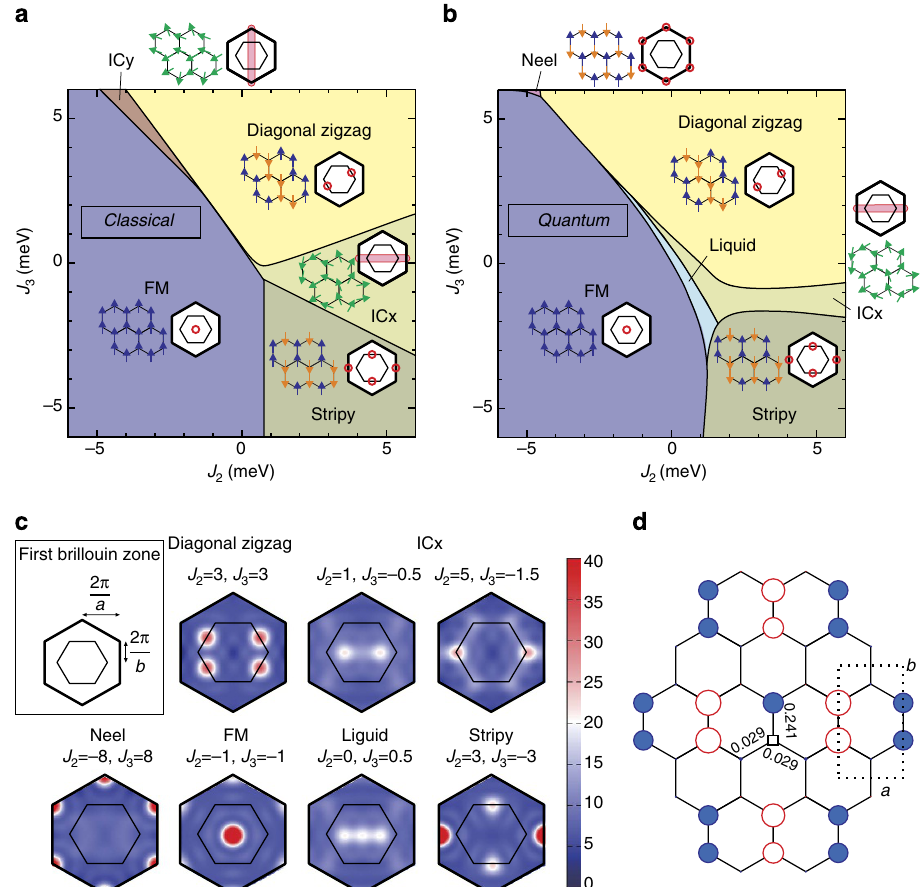
Figure 3 | Magnetic phase diagrams and spin structure factor. Phase diagram of Li213 in the J 2 – J 3 plane with the NN couplings listed in Table 1, along with schematic spin configurations and Bragg peak positions (red circles) for each phase. ( a ) Classical phase diagram of the effective spin T ¼ 1 model on the triangular lattice, found by a numerical minimization of the interaction matrix K (k) in the Brillouin zone (BZ). The actual ground-state configurations in the incommensurate regions ICx and ICy can be much richer than the standard coplanar helix states owing to anisotropy, see text. ( b ) Quantum mechanical phase diagram for the original spin-1/2 model. ( c ) Structure factor S k ð Þ for representative momenta in different phases. Note that in the ICx phase, the peak position ( ± Q a , 0) takes values between 0 o Q a r 2 p / a , depending on J 2 and J 3 . ( d ) Long range spin–spin correlation profiles ~ S i (cid:3) ~ S j (cid:7) (cid:8) at J 2 ¼ J 3 ¼ 3 (that is, inside the diagonal-zigzag phase), as obtained by exact diagonalization (ED) calculations. The reference Ir site is shown as a black square rectangle, positive (negative) correlations are denoted by filled blue (open red) circles whose radii scale with ~ S i (cid:3) ~ S j (cid:7) (cid:8)(cid:11) (cid:11) (cid:11) (cid:11) . We also show explicitly the actual values for the NN